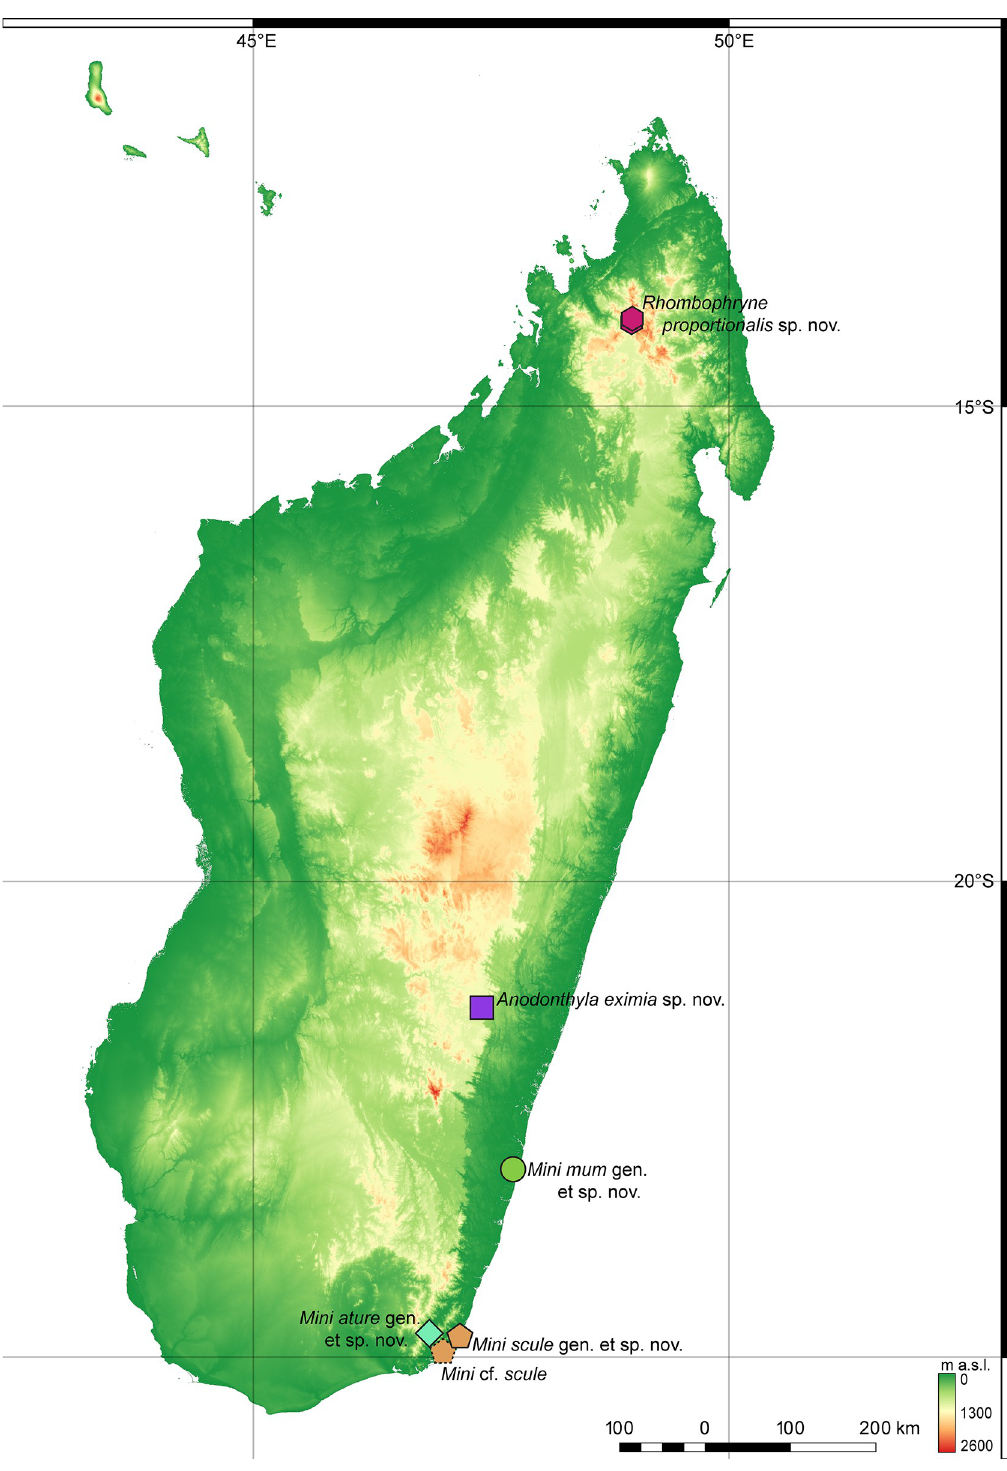
Fig 3. Currently known localities of the new taxa described in this paper. The base map is USGS SRTM 1-Arc second digital elevation model.